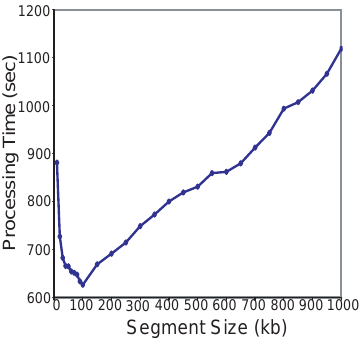
Figure 4. SAGE2Splice Was Optimized for Processing Time by Using Different Genomic Segment Lengths (Ranging from 10 kb to 1,000 kb) For SAGE2Splice performance, 100 kb was determined as the optimal